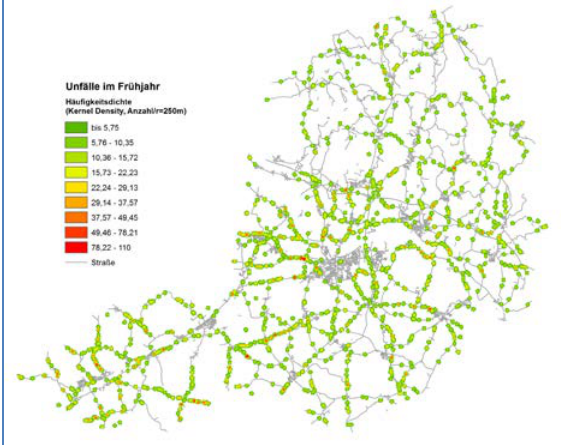
Figure 2 Kernel density of WVC in spring for 250 sections of the road network The spatial distribution of WVC depends on species and season as shown for a selected sub-region in Figure 3 . The pattern during spring, summer and autumn is mainly scattered, while during winter season there is a concentration in forest areas. Also affected species vary, while rabbit (Hase) and wild boars (Schwarzwild) mainly contribute to accidents in spring and summer, the majority of accidents is caused by roe, red and fallow